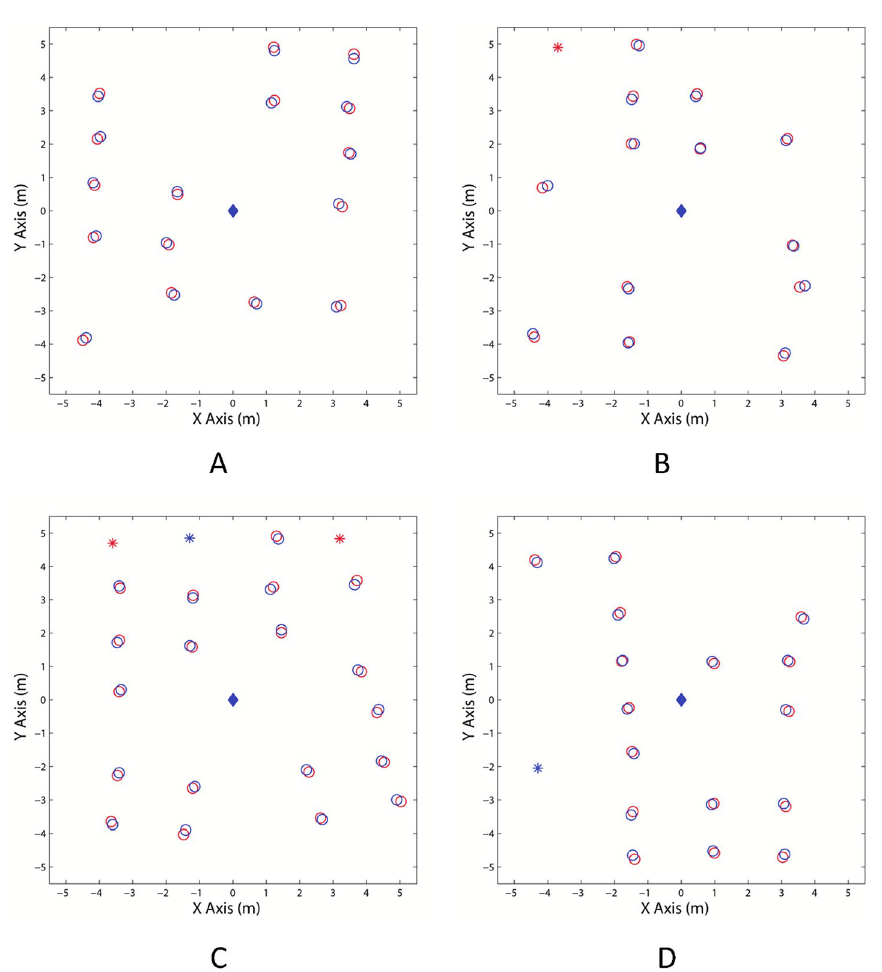
Fig 13. The map of tree positions for manual measured results (red) and estimated results (blue). ( A ) Plot 1; (B) Plot 2; (C) Plot 3; and (D) Plot 4.